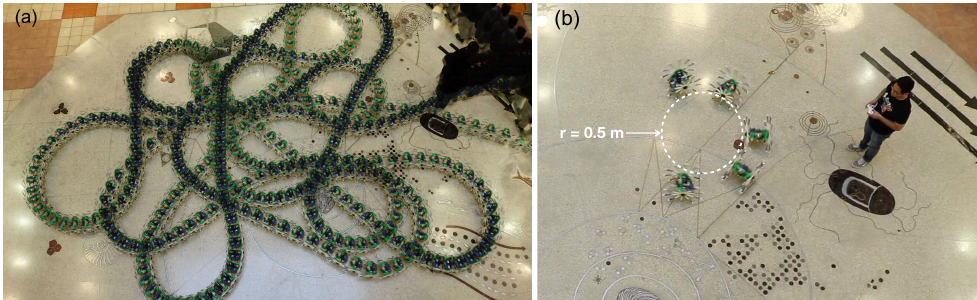
Figure 8. Experimental results for robot turning ( a ) Trajectory of the robot during turning; ( b ) Shortest turning radius of 0.5